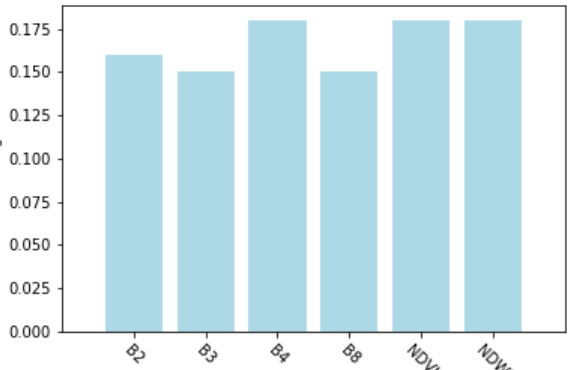
Figure 15. Average importance of the input variables used for time series